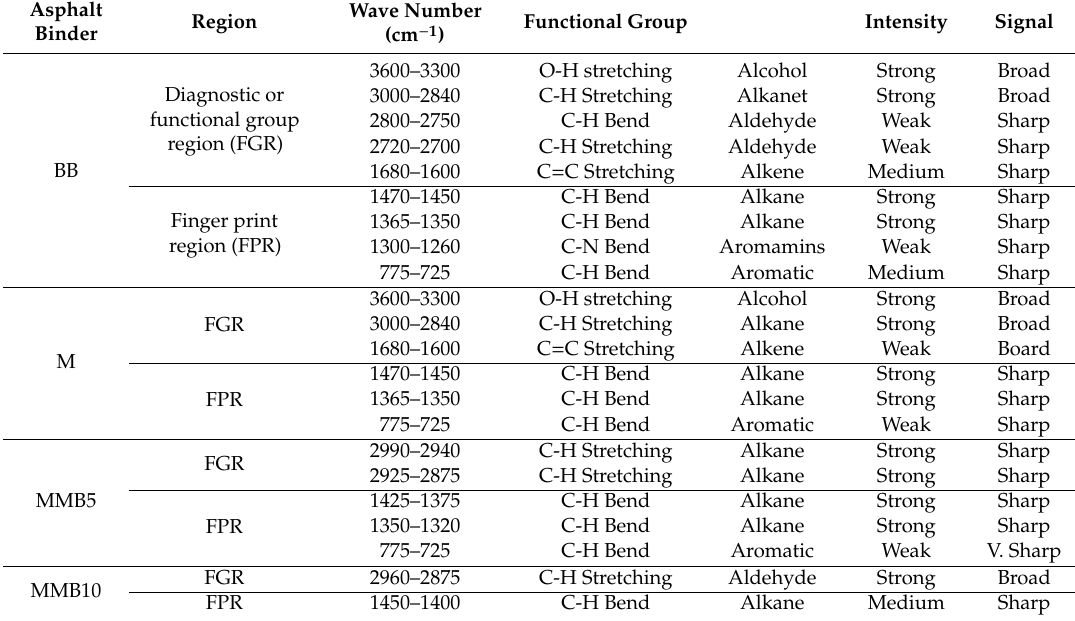
Figure 4. Spectra of un-aged Bitumen binders (BB), M, MMB5, and MMB10. Table 6. Functional groups identified for Molasses (M), Bitumen binders (BB), and molasses modified binders (MMB).